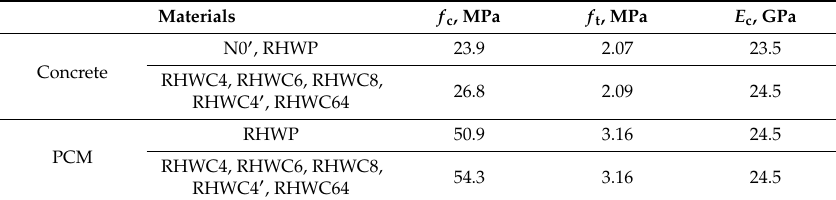
Table 6. Material properties of concrete and PCM.